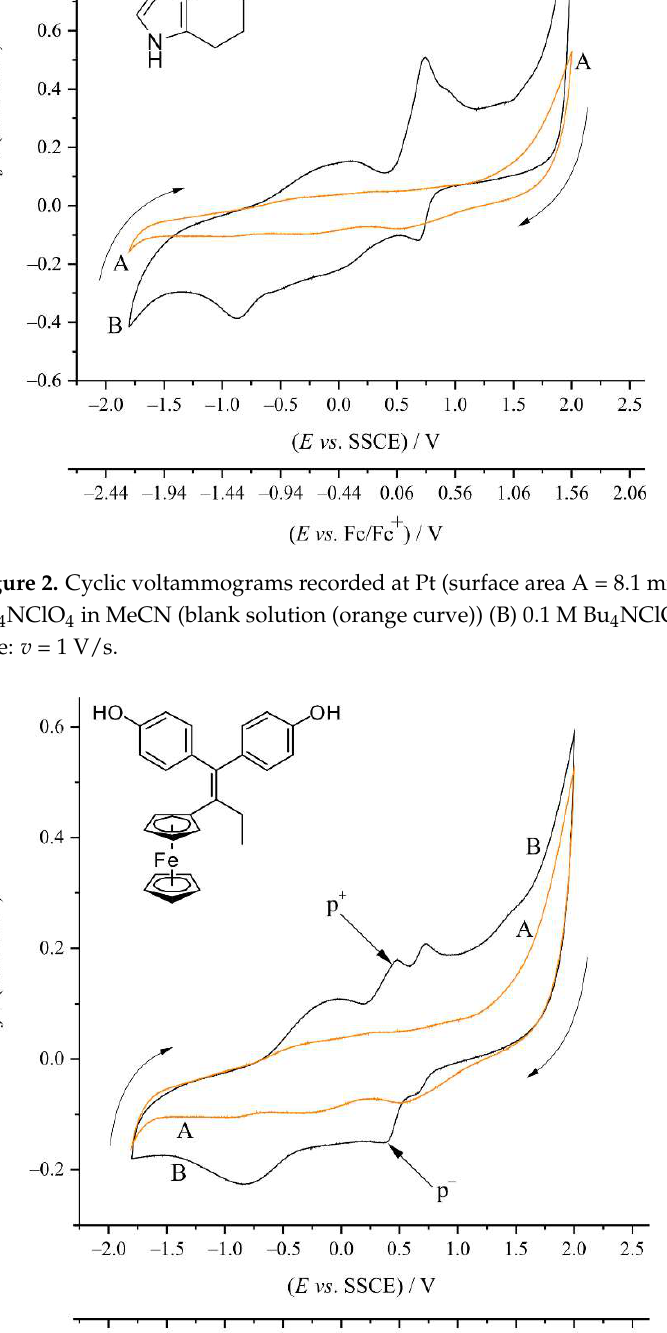
Figure 3. Cyclic voltammograms recorded at Pt (surface area A = 8.1 mm 2 ) in contact with (A) 0.1 M Bu 4 NClO 4 in MeCN and (blank solution (orange curve)) (B) 0.1 M Bu 4 NClO 4 + 1 mM 18 in MeCN. Scan rate: v = 1 V/s . (The assignment of the peak pair p − –p + is discussed in the “Supplementary Scan rate: v = 1 V/s. (The assignment of the peak pair p − –p + is discussed in the “Supplementary Materials”: Section 2.2 and Figures S1 and S2.). Materials”: Section 2.2 and Figures S1 and